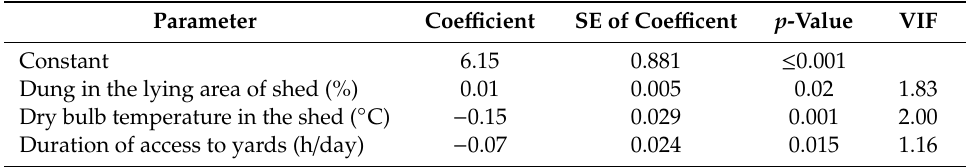
Table 7. Regression analysis of resource-based parameters significantly ( p < 0.05) related to hair cortisol concentration (log 10 pg /